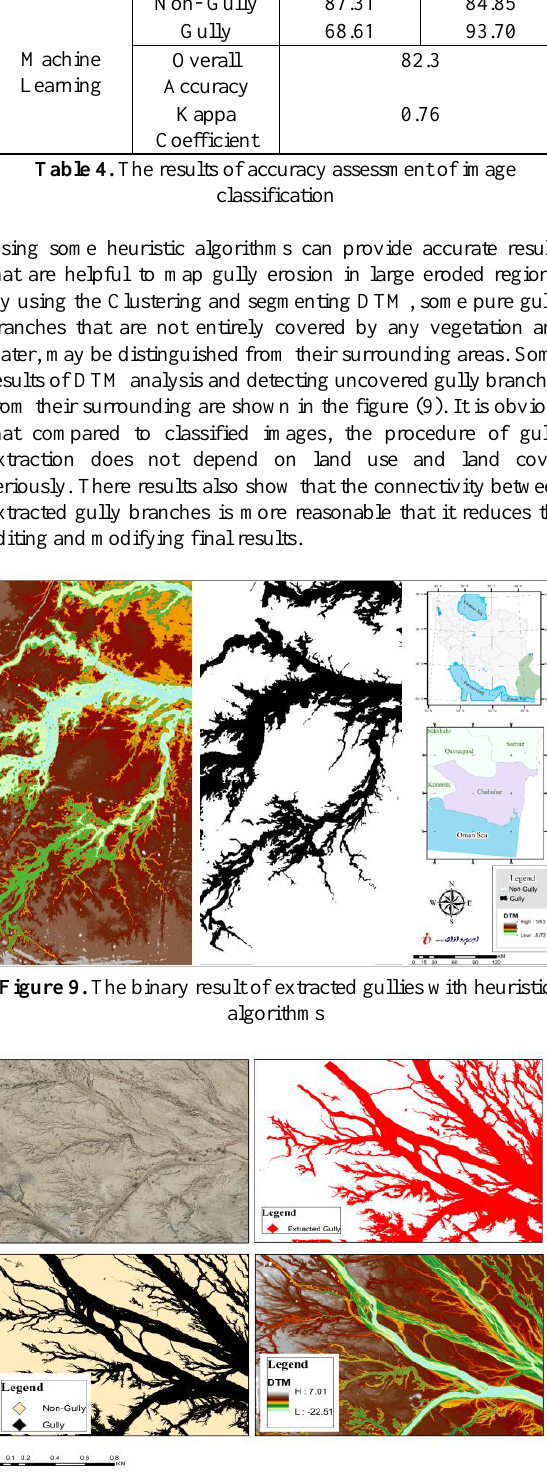
Figure 10. The binary result of extracted gullies with heuristic